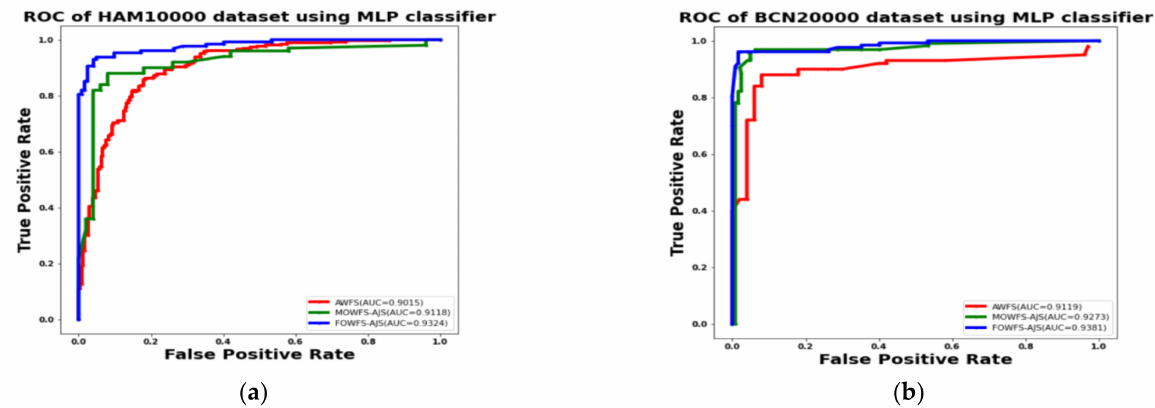
Figure 12. ROC using MLP classifier for ( a ) HAM 10000 dataset and ( b ) BCN 20000